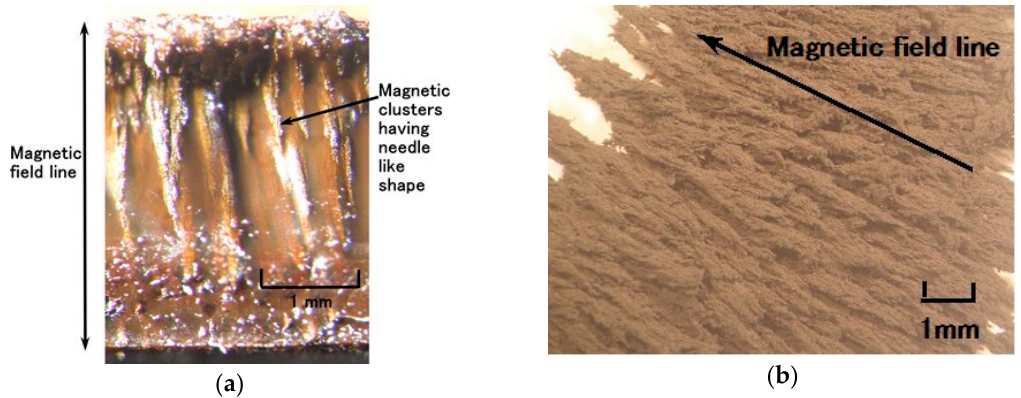
Figure 5. Photograph of cross-section of the MCF rubber made by the present new method magnified by a microscope, shown at ( a ); photograph with microspore of magnetic clusters extracted from the MCF rubber liquid using the magnetic clusters extraction method which was devised by Shimada [17], shown at ( b ).